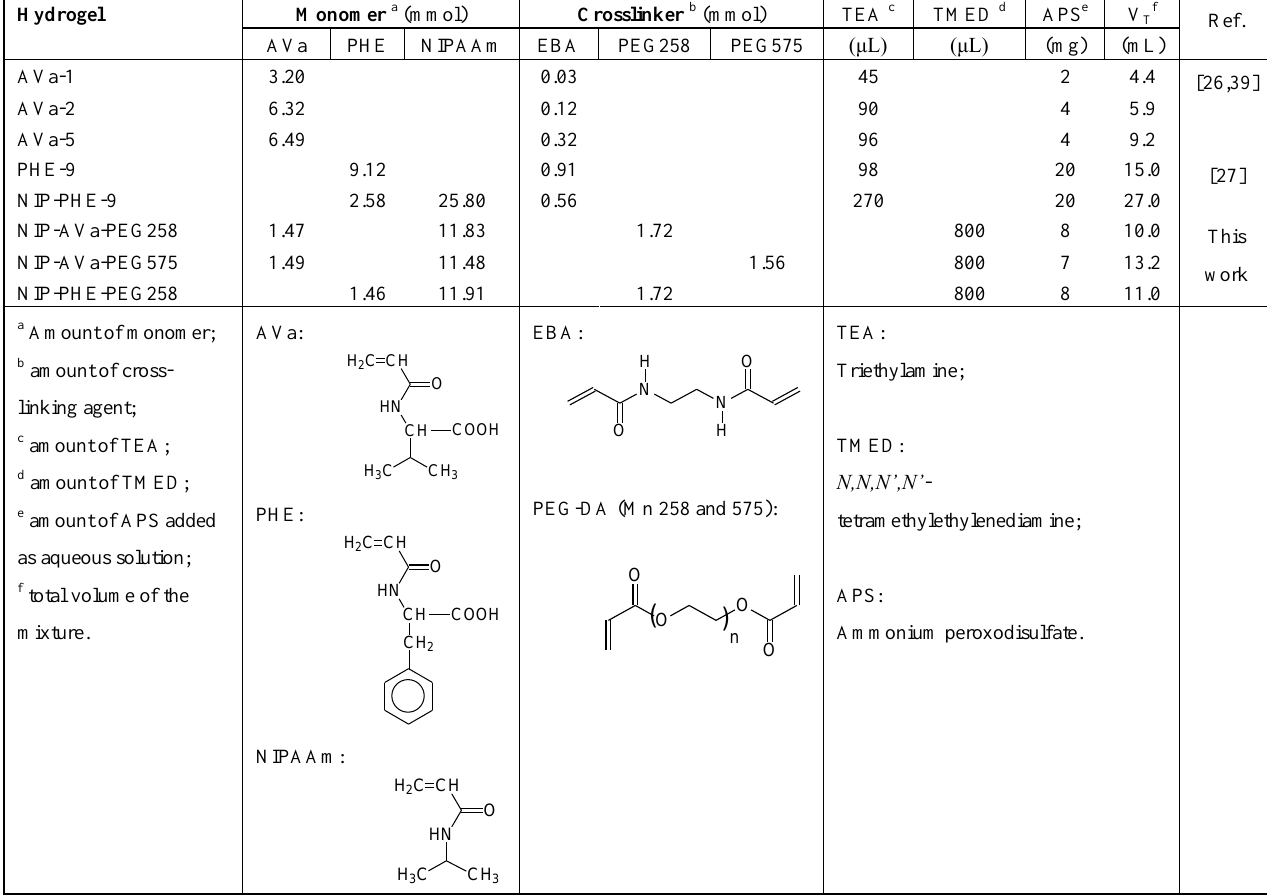
Table 1. Feed composition of the